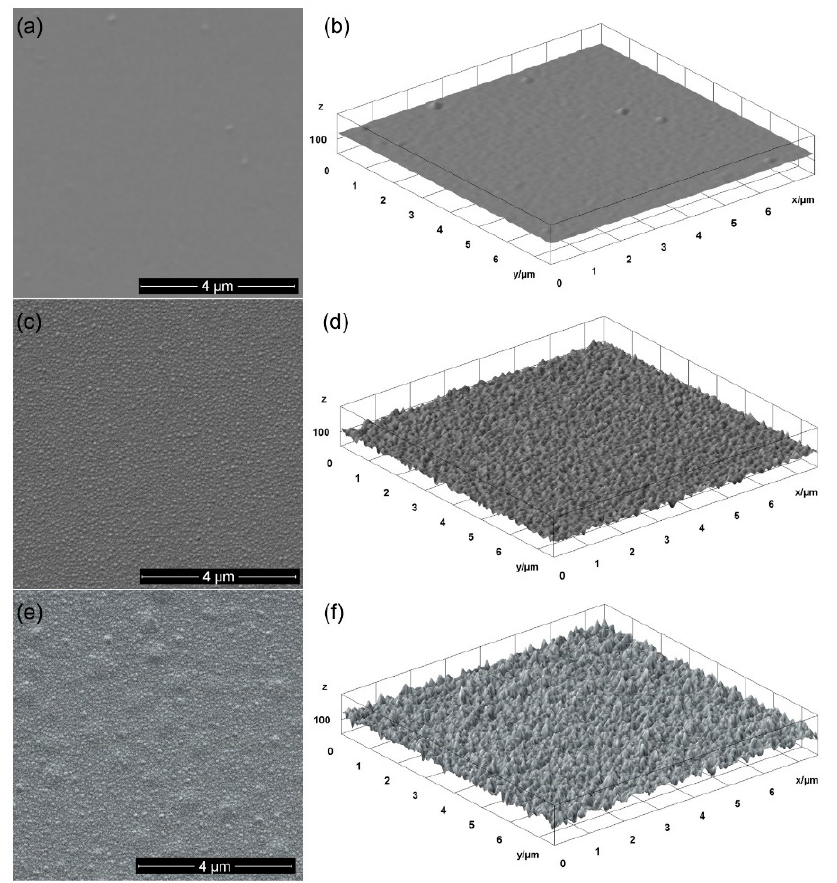
Figure 3. 2D SEM micrograph of CS–HAp coatings obtained at: p = 2 × 10 − 3 mbar ( a ); p = 5 × 10 − 3 mbar ( c ); p = 1.2 × 10 − 2 mbar ( e ). 3D representation of SEM images obtained on CS–HAp coatings: p = 2 × 10 − 3 mbar ( b ); p = 5 × 10 − 3 mbar ( d ); p = 1.2 × 10 − 2 mbar ( f ).